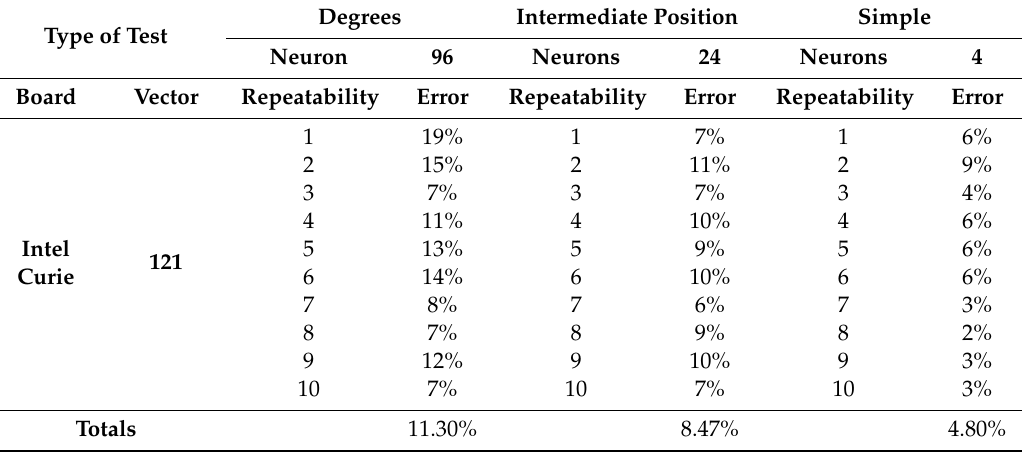
Table 3. Results of the training patterns using a resolution of 11 × 11 pixels.